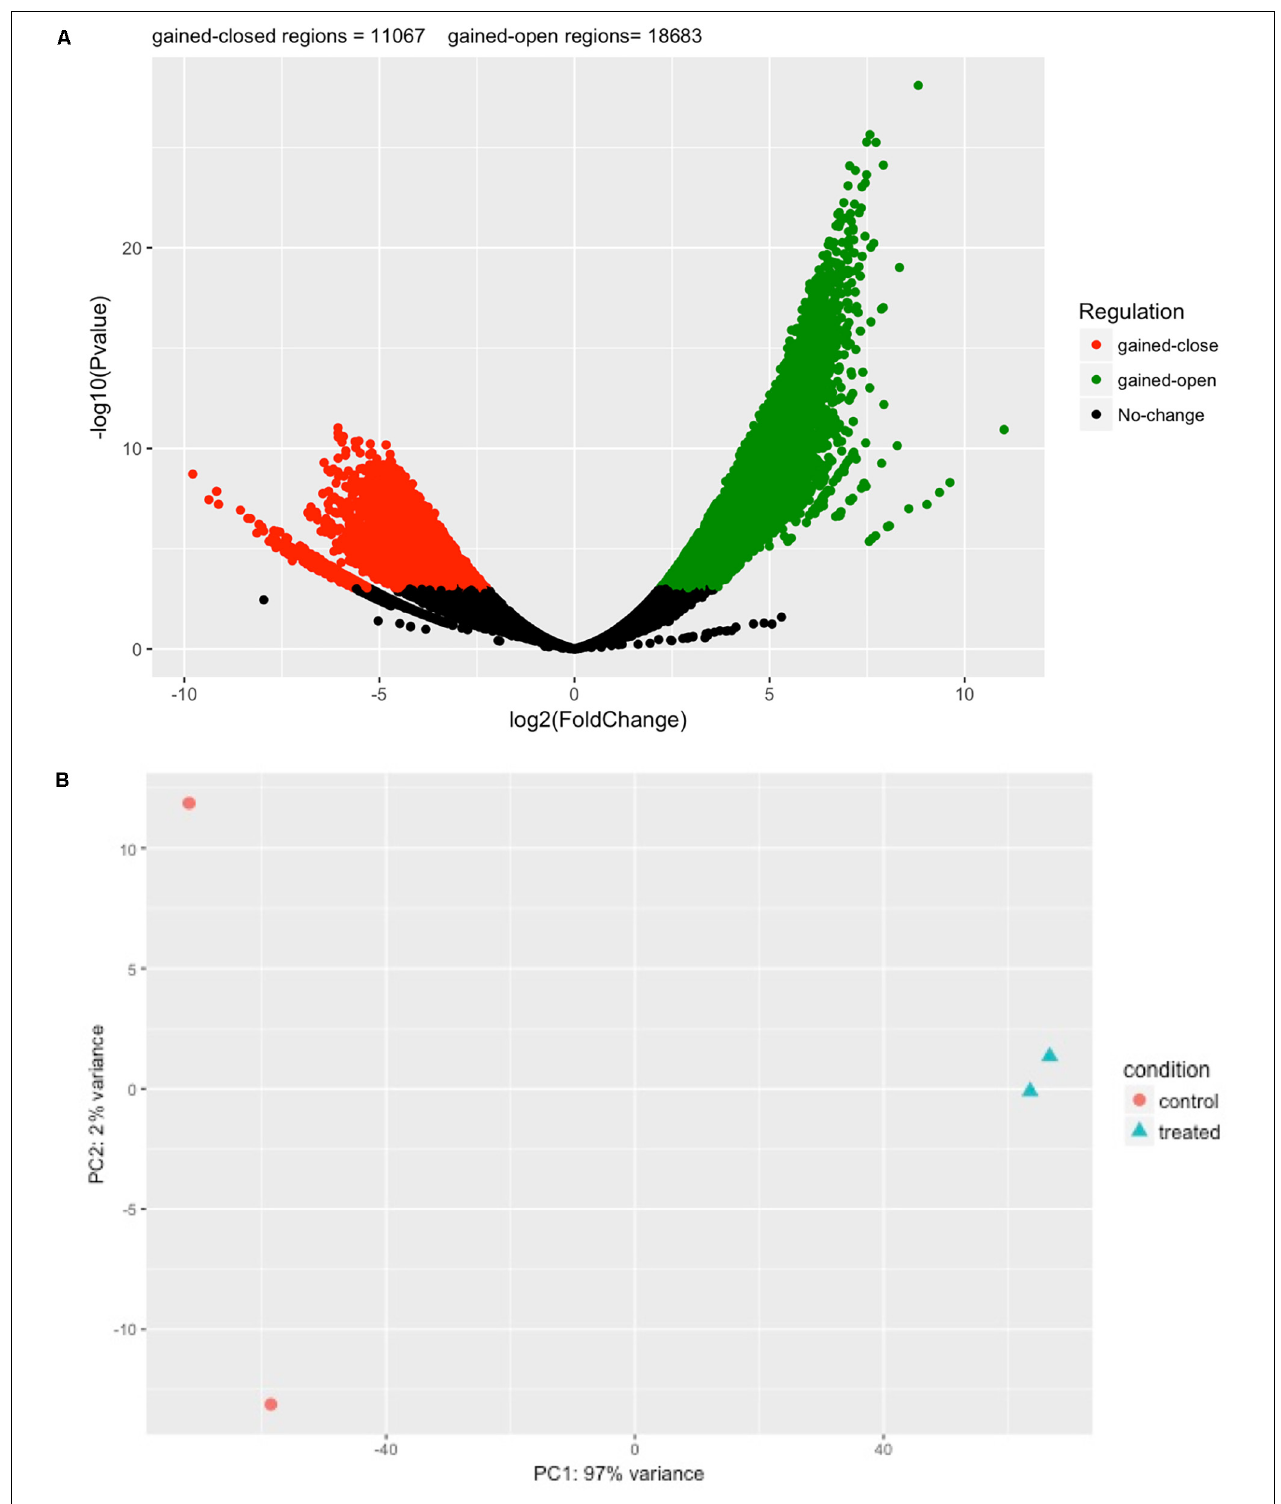
FIGURE 4 | BYL719 induces differentially enriched ATAC-seq peaks in T47D cells. (A) A volcano plot showing the differentially enriched peaks between BLY719 and DMSO-treated T47D cells. In total, 29,750 regions were found with differentially enriched ATAC-seq signals. Out of which 18,683 regions were gained-open (increased in chromatin accessibility) and 11,067 were gained-closed regions (decreased in chromatin accessibility) before and after BLY719 treatment of T47D cells. (B) Principal component analysis plot for the control and treatment replicates